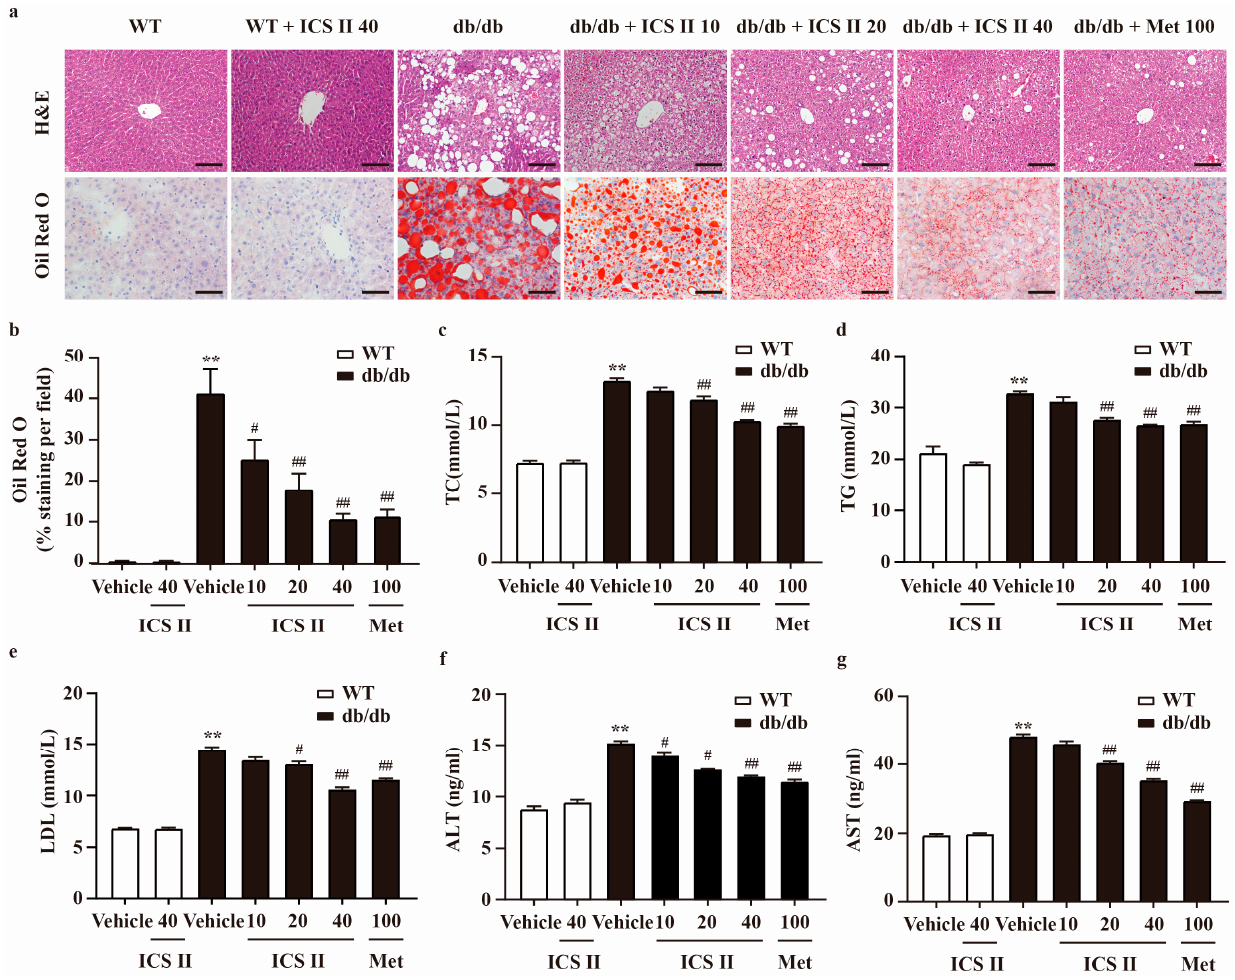
Figure 2. ICS II improved lipid profiles in the serum and hepatic steatosis of db/db mice. ( a ) H&E staining ( × 200, scale bar = 100 µ m) and Oil red O staining ( × 400, scale bar = 50 µ m). ( b ) Quantitation of Oil red O staining. The area of positive staining per field were calculated using ImageJ. ( c ) TC level ( n = 8). ( d ) TG level ( n = 8). ( e ) LDL level ( n = 8). ( f ) ALT level ( n = 8). ( g ) AST level ( n = 8). Data were presented as mean ± SEM. ** p < 0.01 versus WT group; # p < 0.05, ## p < 0.01 versus db/db group.